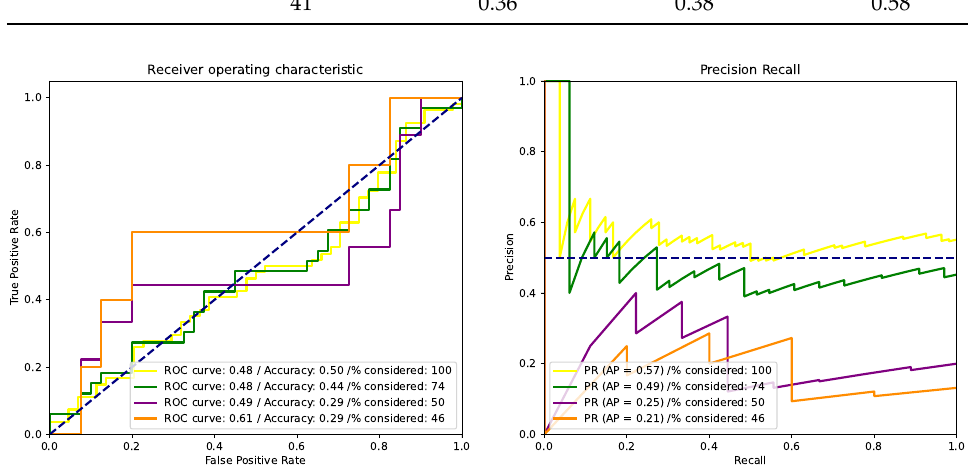
Figure A5. ROC and PR curves for the methylation percentage metric. Tumor-centered, FLAIR